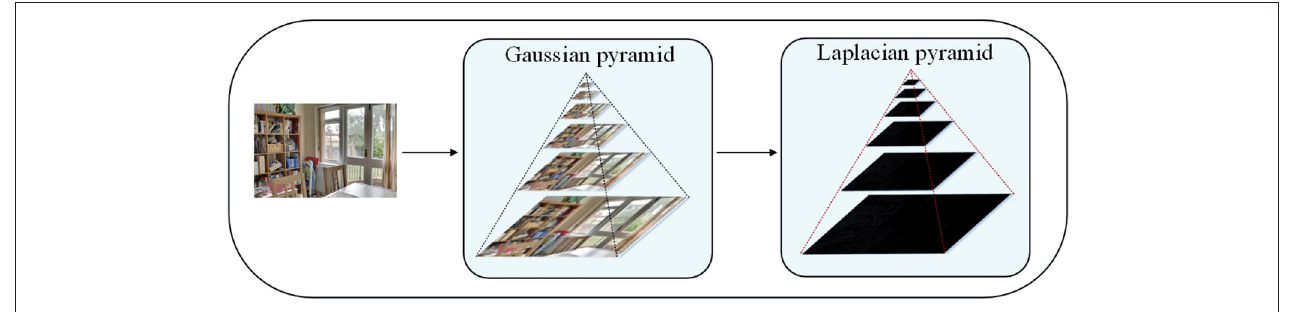
FIGURE 2 | The Laplace decomposition process of the image.